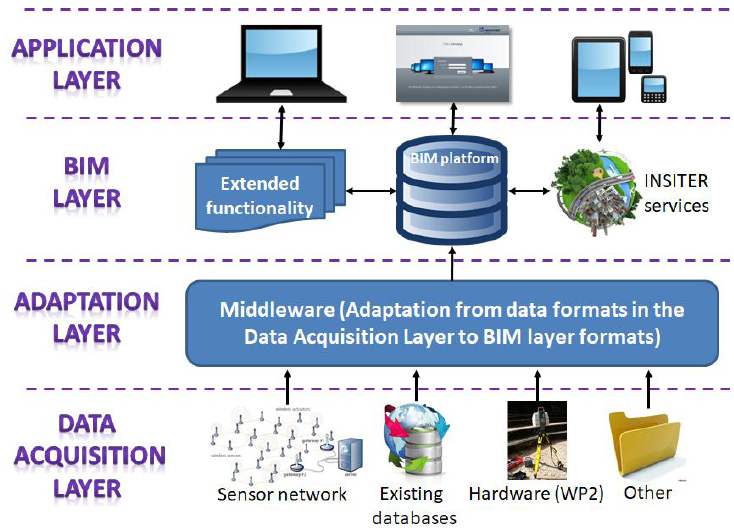
Figure 1. Architecture framework for the self-inspection tools based on Industry Foundation Classes (IFC).